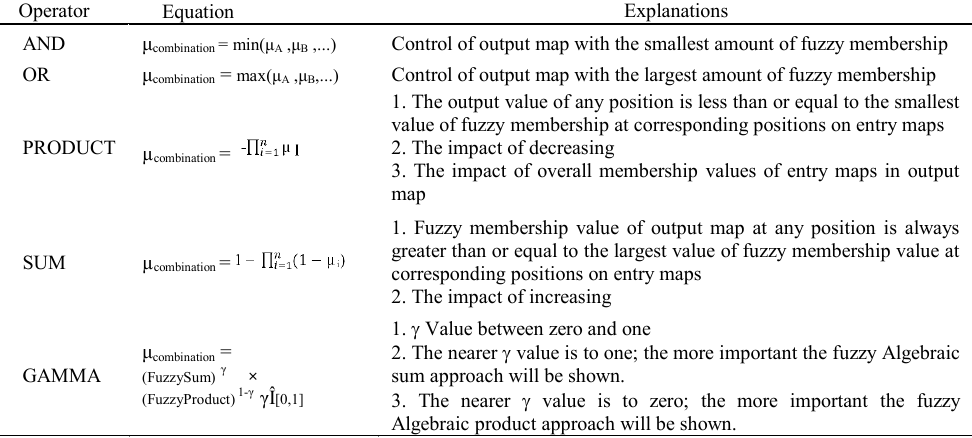
Table 1: Types of fuzzy